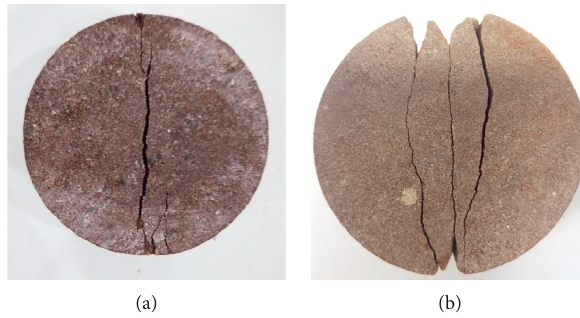
Figure 13: Failure of specimens No. 1-17 (a) and No. 1-18 (b) under arc